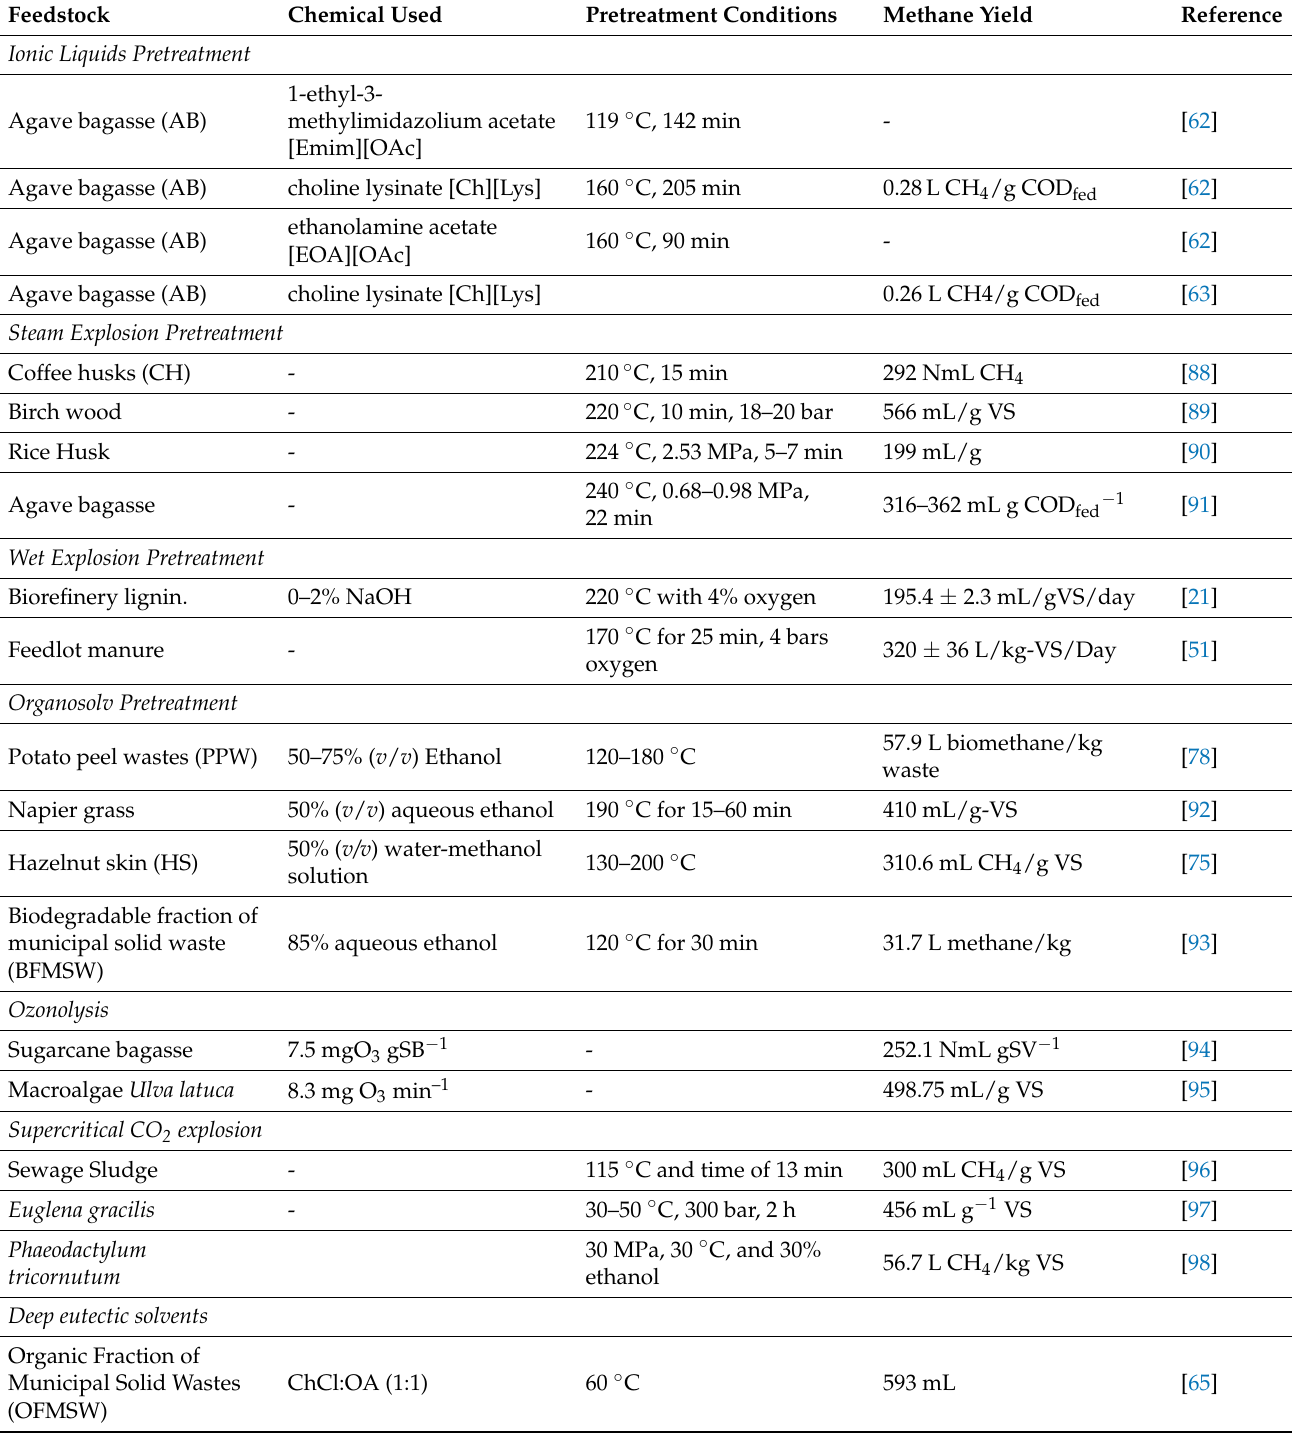
Table 2. Innovative pretreatment techniques to enhance degradation of lignocellulosic materials under anaerobic